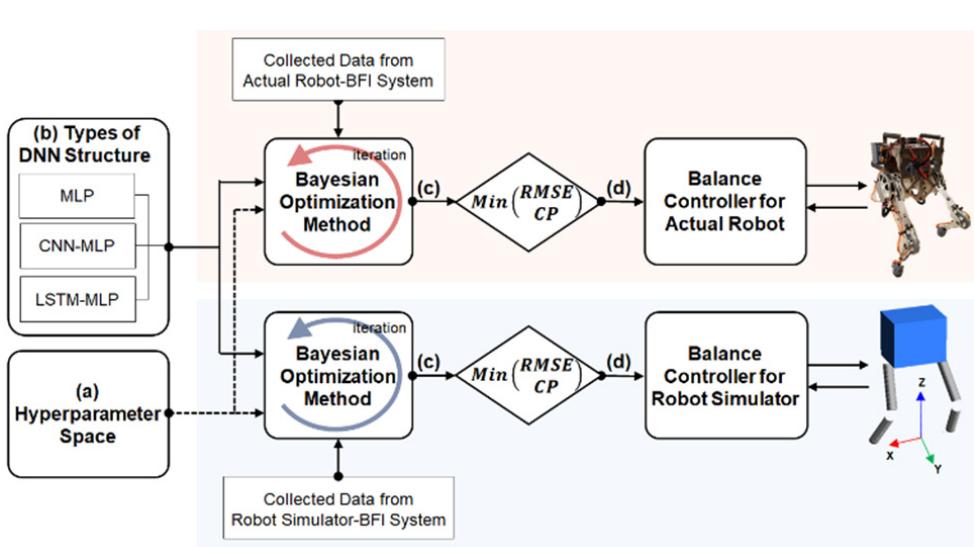
Figure 7. Optimization process for the hyperparameters of DCM Net and W Net . The Bayesian optimization method iteratively explores ( a ) types and range of hyperparameters for ( b ) each of the three types of DNN structures. ( c ) The three types of DNN structures were optimized to lower the RMSE between the predictions from the DNN and the target values collected via the BFI system. ( d ) The performance of the optimized MLP, CNN-MLP, and LSTM-MLP were compared to select the best structure for the balance controller by considering the RMSE and the computation time (CP).